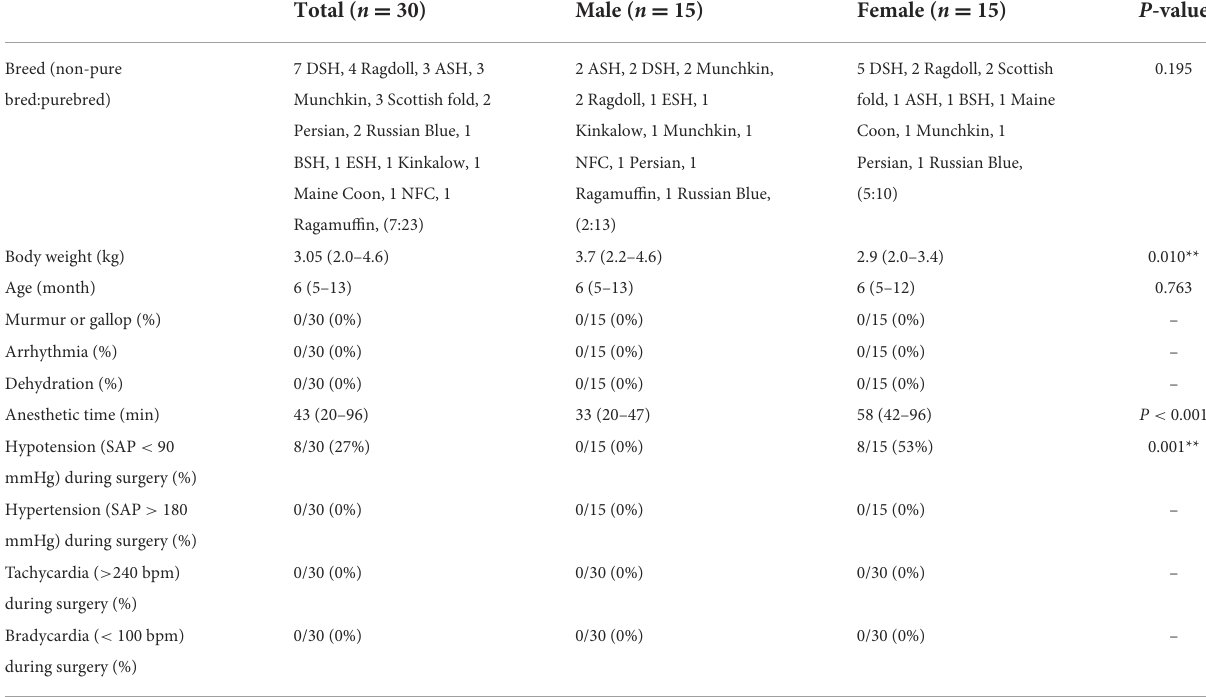
TABLE 1 Summary of clinical data before and during surgery in all